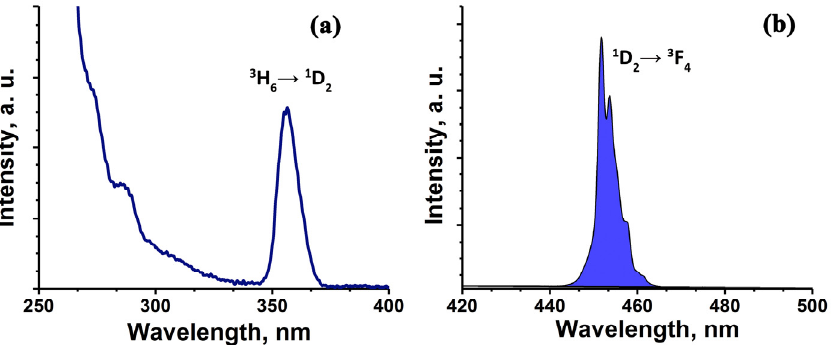
Figure 6. ( a ) PLE ( λ em = 477 nm) and ( b ) PL ( λ ex = 356 nm) spectra for Ca 9 Gd 0.9 Tm 0.1 (PO 4 ) 7 . The emission bands of Tm 3+ and Sm 3+ ions, are registered in PL spectrum of Gd 0.8 Tm 0.1 Sm 0.1 at λ ex = 356 nm, which corresponds to intracenter excitation of Tm 3+ ions (Figure 7). Thus, energy transfer from Tm 3+ to Sm 3+ occurs. In contrast, energy transfer from Sm 3+ to Tm 3+ is not registered, which is confirmed by the absence of Tm 3+ emission lines under excitation at λ ex = 404 nm (Sm 3+ intracenter excitation).